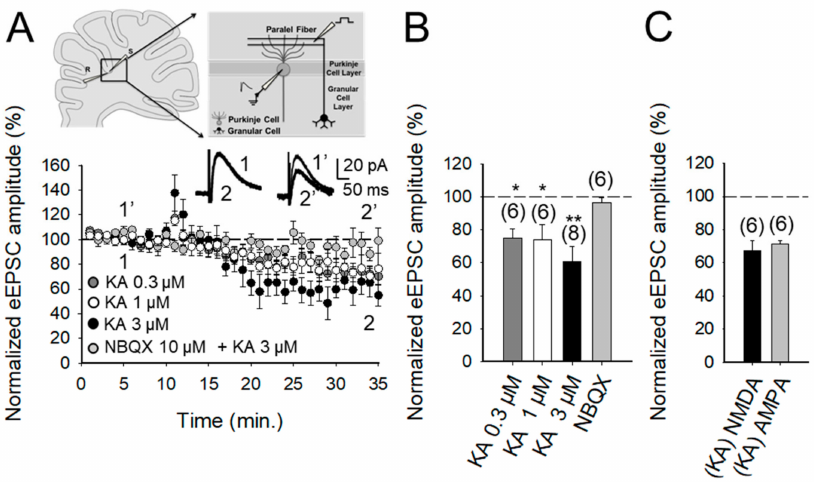
Figure 1. Kainate (KA) reduces the evoked excitatory postsynaptic current (eEPSC) amplitude at parallel fibers-Purkinje cell (PF-PuC) synapses of the cerebellum. ( A ) The picture shows the experimental setup. The graph shows the time course of the KA (0.3, 1 and 3 µ M) e ff ect on eEPSC amplitude in the absence (dark grey, white and black symbols) and presence of NBQX for KA3 µ M (grey). The inset shows traces before and after KA 3 µ M treatment in the absence (1, 2) and in the presence of 10 µ M NBQX (1 (cid:48) , 2 (cid:48) ). ( B ) Quantification of modulation and dose dependency of the KA e ff ect on eEPSC amplitude in the absence and presence of NBQX. ( C ) E ff ect of KA (3 µ M) on NMDA and AMPA receptor-mediated currents. Note that the e ff ect of KA on these currents is indistinguishable. The number of slices (from two to three mice) is indicated in parentheses at the top of each bar. Results are expressed as the means ± SEM (* p < 0.05, ** p < 0.01, Student’s t